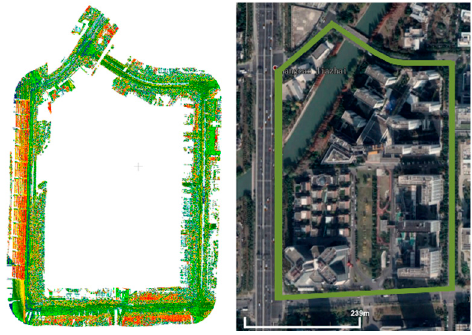
Figure 11. The general area of the study sites.